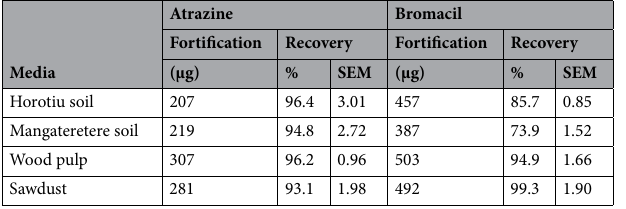
Table 2. Recovery of atrazine and bromacil from the eight Day-0 samples compared to the original fortification.